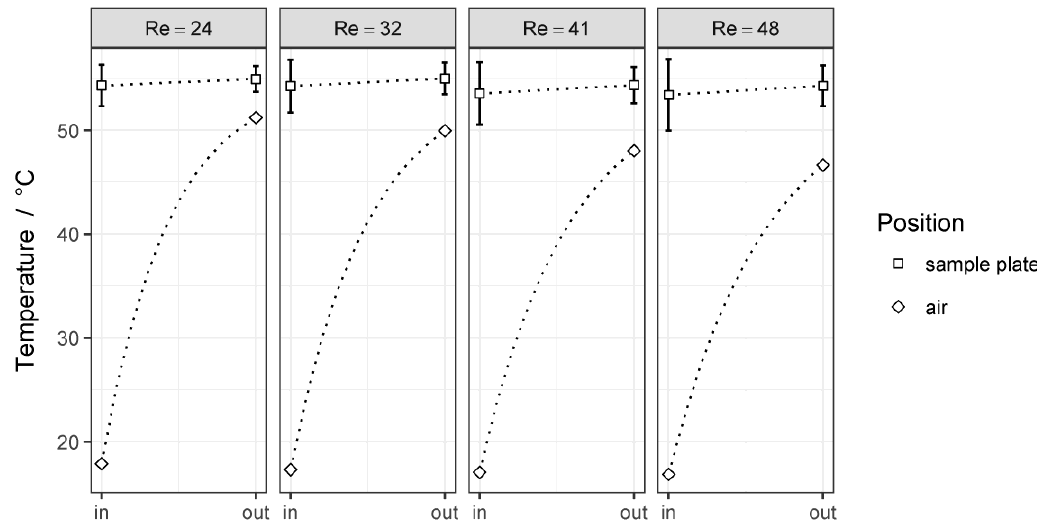
Figure 7. Mean inlet and outlet temperatures of the air and sample plate with respect to different Reynolds numbers Re air,st for the wire structure. Twice the standard deviation of the measured temperature value is given for the sample plates as error bars, representing 95% of the data.